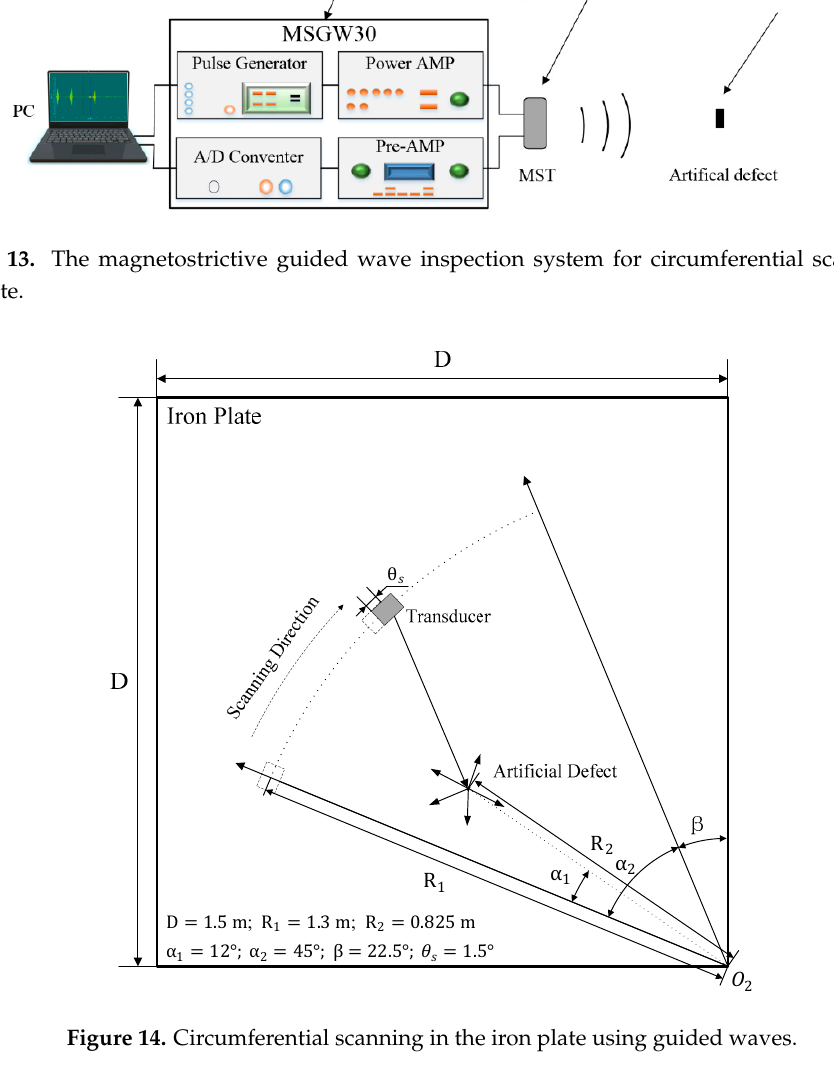
Figure 14. Circumferential scanning in the iron plate using guided waves.